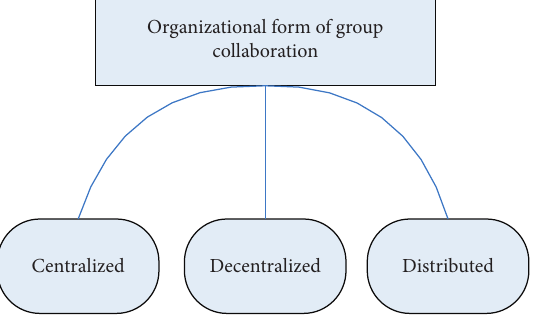
Figure 3: Organization form chart of group Table 1: Basic information of experimental data collection.